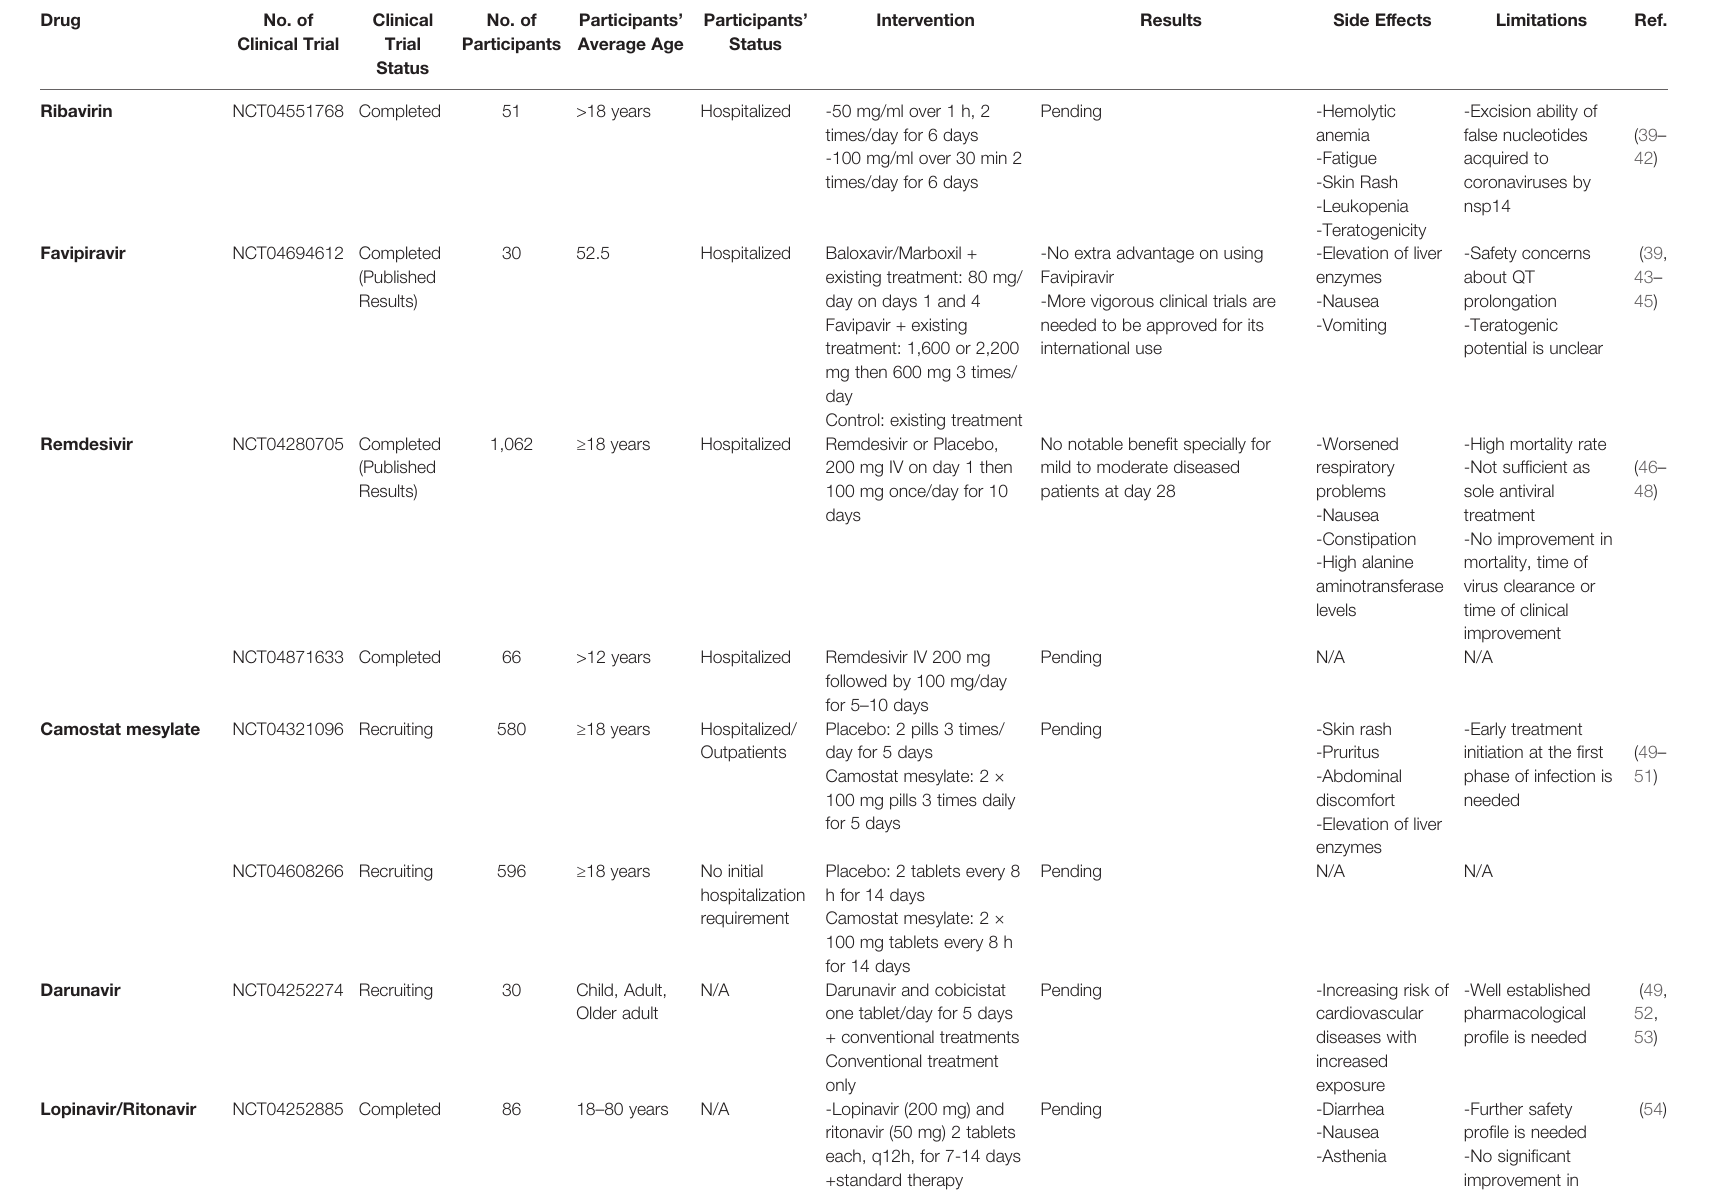
TABLE 1 | A list of currently available drugs for the treatment of SARS-CoV-2.